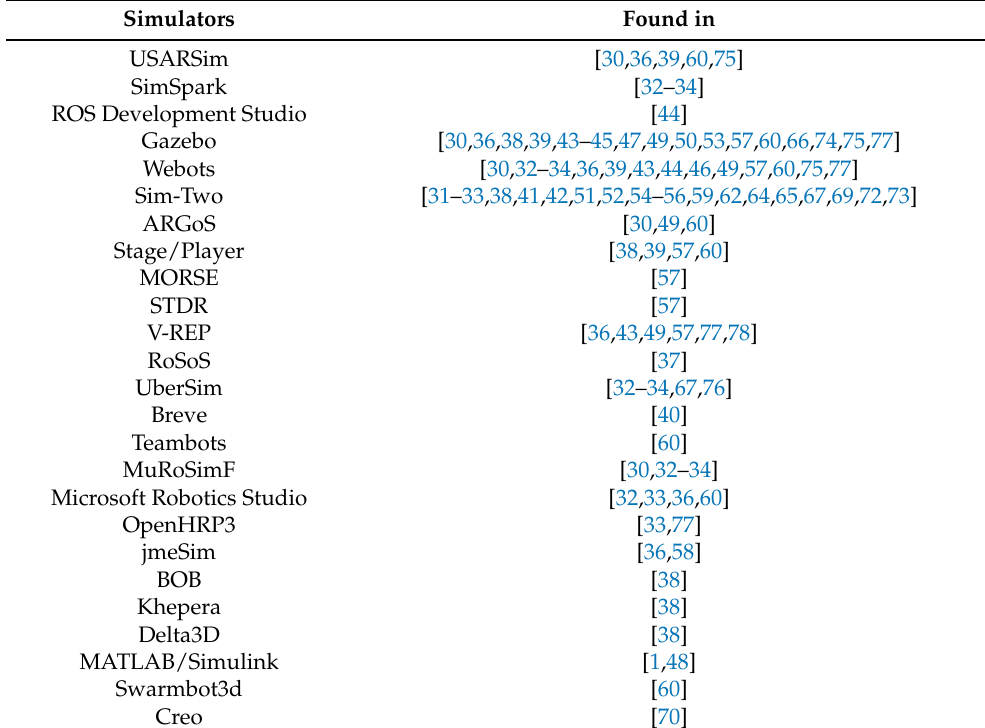
Table 4. All the simulators mentioned throughout the full-read papers.